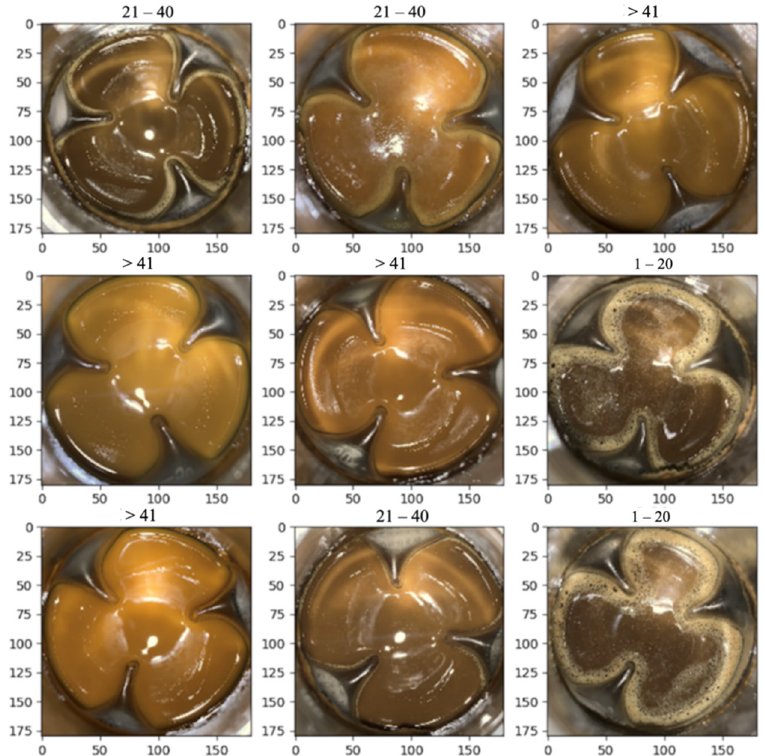
Figure 4. A demo of different classifications, 1–20, 21–40, and >41 representing 1–20, 21–40, and >41 g/L PMLA production, with their corresponding pictures.